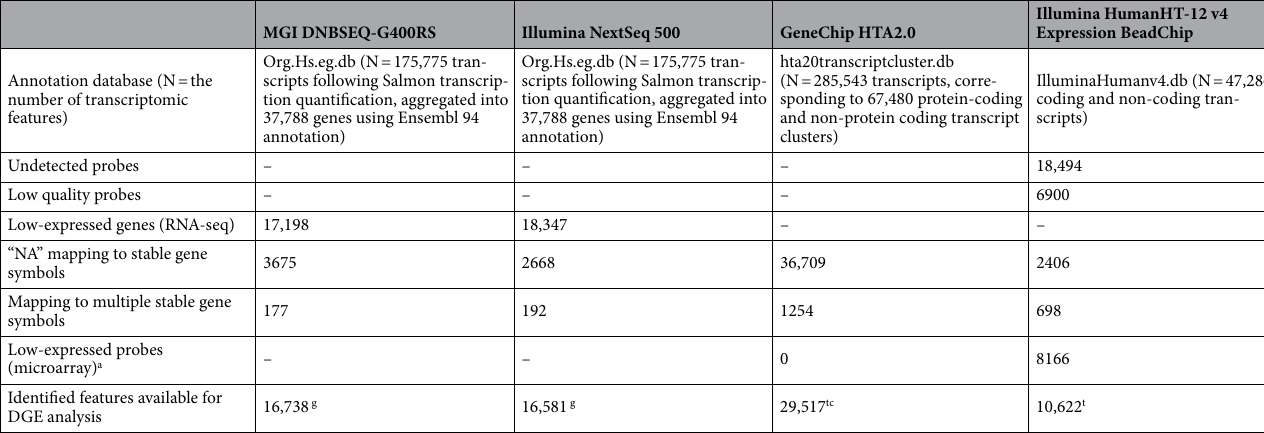
(Table 2). Subsequent data normalisation and filtering unveiled 29,517 transcript clusters (GeneChip) and 10,622 transcripts (BeadChip) for DGE analyses (Table 2). Briefly, 18,494 and 6900 probes were removed as undetected and low-quality probes, respectively, from the BeadChip (Table 2). While 8166 probes were removed due to low average expression (cutoff value: 5.1) in the BeadChip data, no probes of low expression were excluded from the GeneChip (Table 2 and Supplementary Fig. S5). No significant surrogate variables representing underlying biases, which may arise from library preparation and/or scanning, were observed in the two microarrays. Unsupervised principal component analysis (PCA) revealed substantial variance, estimated using the top 500 genes ranked by expression variance across all samples. Variances explained by the principal component 1 (PC1) and principal component 2 (PC2) were: 69% versus 5% (MGI), 44% versus 9% (Illumina), 58% versus 14% (GeneChip), and 78% versus 7% (Beadchip) (Supplementary Fig. S6). Gene clustering of the top 30 genes of high variance showed a good distinction across the time points in all datasets (Fig. 1). Nevertheless, a more distinctive pattern was observed following MGI RNA-seq compared to Illumina RNA-seq and GeneChip (Fig. 1a vs b,c). Despite more samples were analysed using the BeadChip in 18 subjects, higher variances of the top 30 genes were found following MGI RNA-seq (Fig. 1a vs d). The DESeq2 13 and limma 14 DGE analyses yielded 1552 genes (MGI), 582 genes (Illumina), 252 transcript clusters (GeneChip) and 2372 transcripts (BeadChip), exceed- ing the pre-defined thresholds (RNA-seq: fold change of 1.2 and s value of 0.005; microarray: fold change of 1.2 and BH adjusted p value of 0.05; note that the probability thresholds bound to the fold change of 1.2) (Table 3). Among the coding genes characterised by the MGI and Illumina RNA-seq and GeneChip, a significant propor- tion was unique to MGI RNA-seq (66.8% at EPO4 and 54.5% at Post7) (Supplementary Table S4). Substantial proportions of these MGI genes exceeded an absolute fold change of 2 (12.4% at EPO4 and 18.0% at Post7) as well as captured moderate changes between 1.2 and 2 (54.4% at EPO4 and 36.5% at Post7), when compared to the coding genes determined by Illumina RNA-seq and GeneChip (ranging from 0 to 19.4%) (Supplementary Fig. S7 and Supplementary Table S4). Furthermore, strong correlations were observed between the MGI and Illumina RNA-seq platforms ( r = 0.74 at EPO4 and r = 0.85 at Post7, P < 2E−16; Fig. 2a,d), whereas the correla- tions ranged from very weak ( r = 0.2) to moderate ( r = 0.7) when compared RNA-seq to GeneChip ( P < 0.0003; Fig. 2b,c,e,f). Overall, the MGI total RNA DNB-seq resulted in an increased sensitivity in detecting differential gene expression in healthy individuals following the rHuEPO administration compared to the Illumina mRNA- seq and GeneChip (Fig. 2, Supplementary Fig. S7 and Supplementary Data 1). Functional enrichment analyses unveiled genes linked to erythropoiesis as well as non‑eryth‑ ropoietic functions of EPO. To explore the biological functions of the transcriptomic features identified from sequencing and microarray, we performed a standard GSEA run (v4.0.3) subjected to 1000 phenotype permutations 15,16 for all datasets, using the MSigDB (v7.2) 15,17 hallmark (H) 18 and Gene Ontology (C5; BP: GO biological process) 19,20 collections of functional gene sets. As expected, heme metabolism emerged as the most significantly enriched gene set following the analysis of 50 hallmark gene sets (FDR: MGI = 0.011 EPO4, Illu- mina = 0.033 EPO4, GeneChip ≤ 0.017 EPO4/Post7 and BeadChip ≤ 0.004 EPO3/4/5/Post7/8; Supplementary Table S5).This observation is in line with the changes in reticulocyte and haematocrit during and post rHuEPO administration in the same cohort of samples, previously reported 7,8 . Leading edge genes included 144 (MGI; EPO4), 105 (Illumina; EPO4), 125/96 (GeneChip; EPO4/Post7) and 101/103/103/97/84 genes (BeadChip; EPO3/4/5/Post7/8), contributing to the heme metabolism enrichment scores (Supplementary Data 2). Fifty-six leading edge genes overlapped across all platforms and across the time points (Supplementary Data 2). Of the